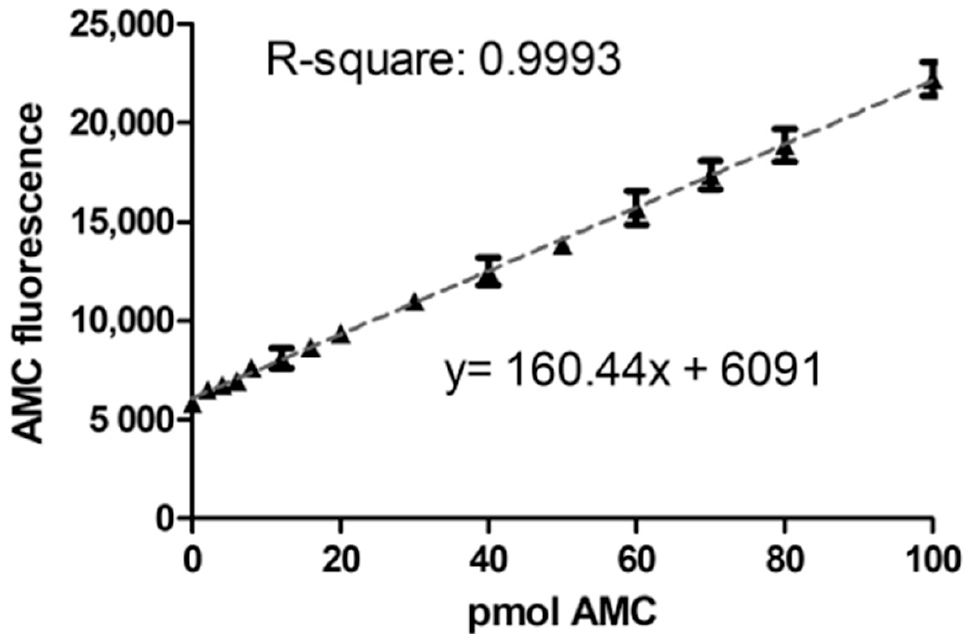
Figure 1. Linearity of the AMC standard curve. AMC-standards were prepared as outlined in Section 4.4. Raw AMC fluorescence (in artificial units) was plotted against the corresponding AMC amount in pmol. The slope, y-intercept, and R-square were calculated by linear regression analysis. Symbols show the mean ± SD of five independent analyses.